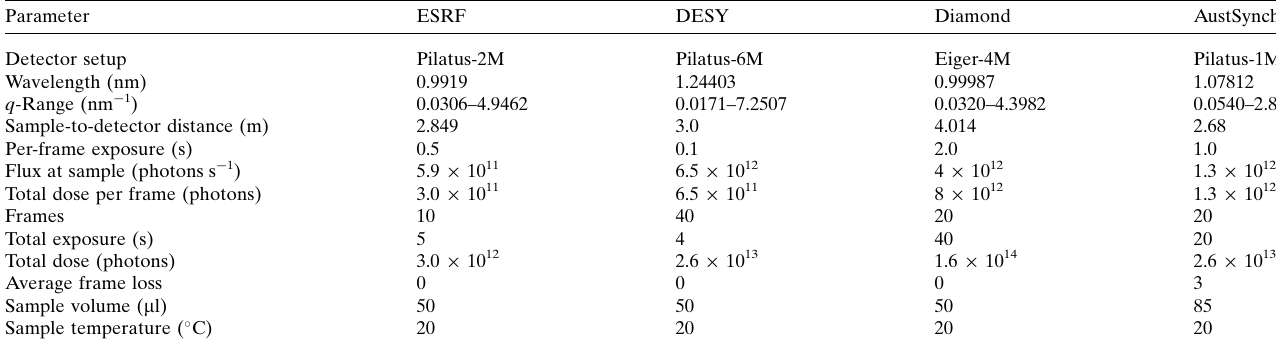
Table 1 Measurement parameters at the four synchrotron beamlines. Note that total dose assumes that all frames have been included for